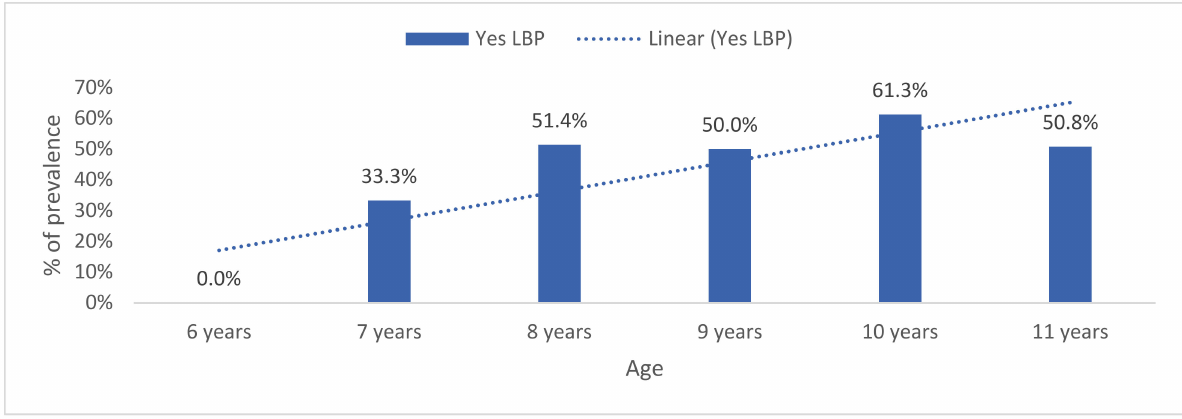
Figure 3. Lifetime prevalence of low back pain by